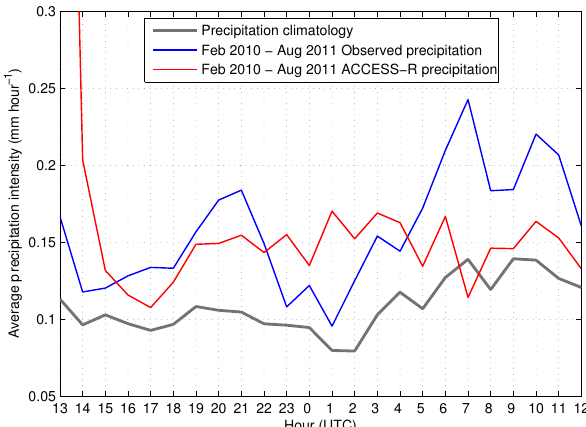
Fig. 10. Diurnal cycle of the observed and the ACCESS-R precipi- tation forecasts. Precipitation climatology (thick gray line) is based on a period from September 1991 to February